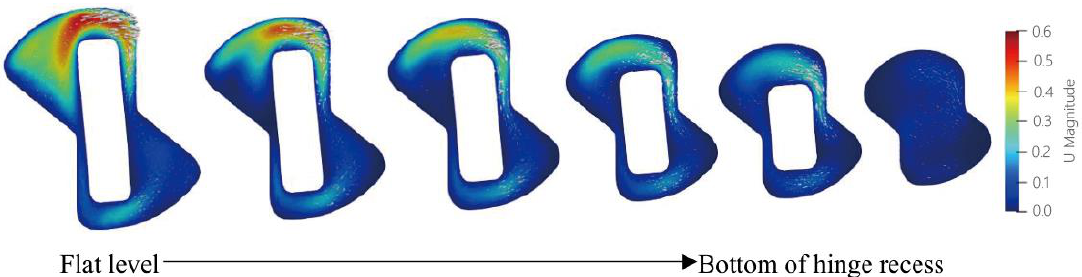
Figure 14. Variations of velocity profile with distance from the valve at the peak velocity phase (Newtonian model).